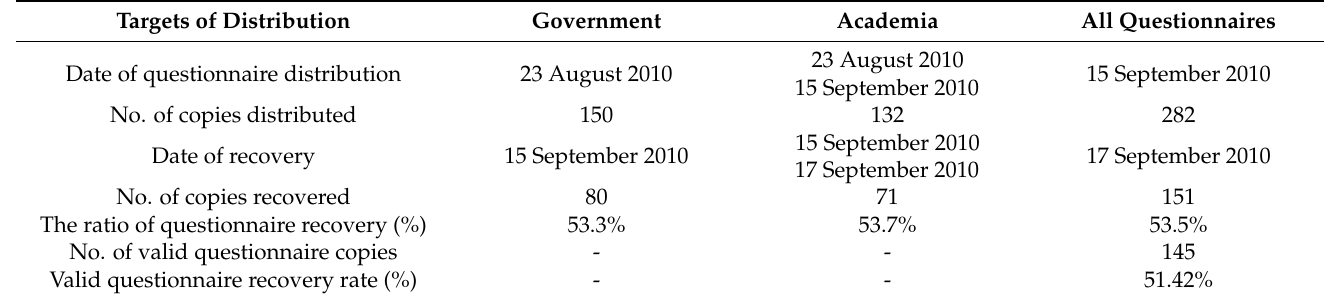
Table 4. Sampling design and valid number of questionnaire copies.